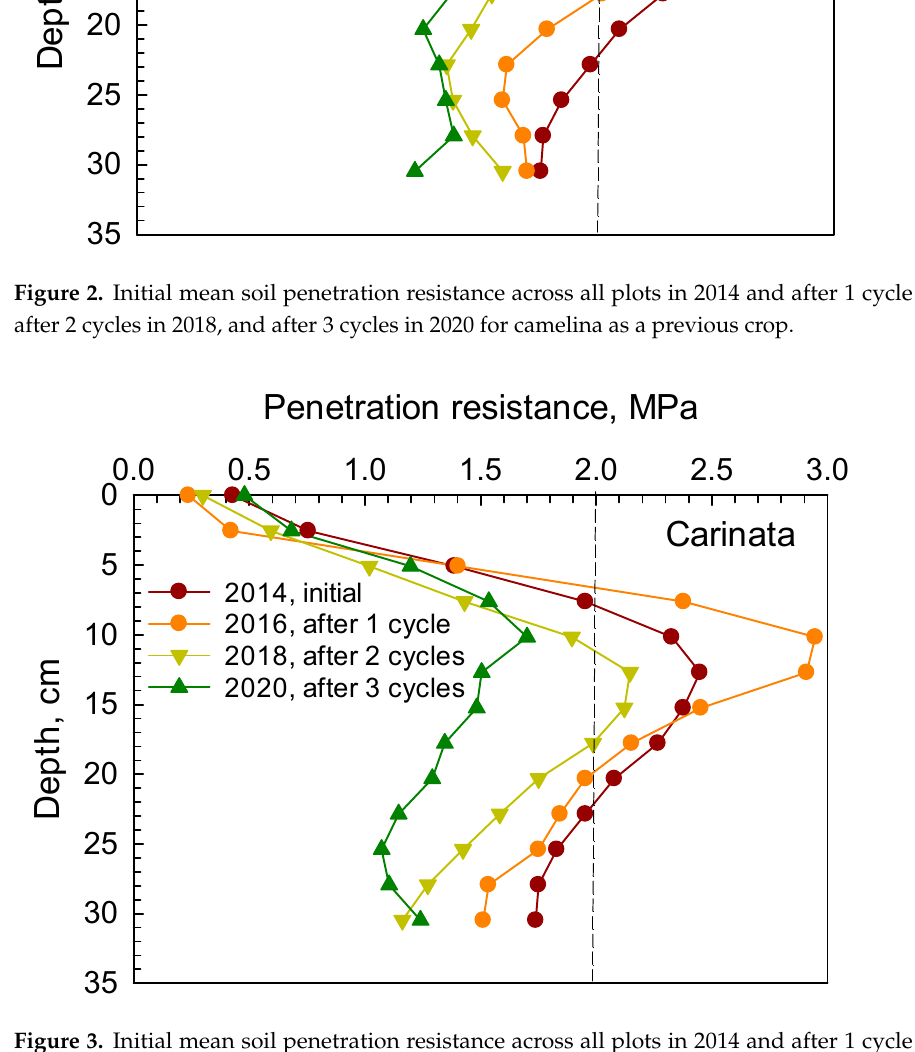
Figure 4. Initial mean soil penetration resistance across all plots in 2014 and after 1 cycle in 2016, after 2 cycles in 2018, and after 3 cycles in 2020 for cover crop mix as a previous crop.